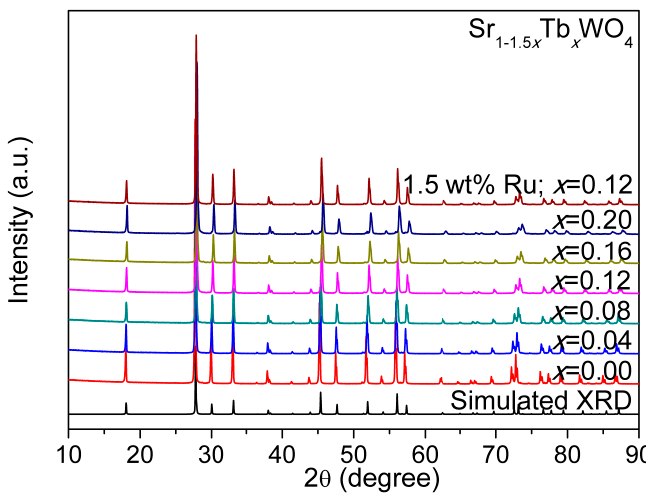
Figure 10. The XRD patterns of the solid solutions, and the recycled samples after photocatalysis.